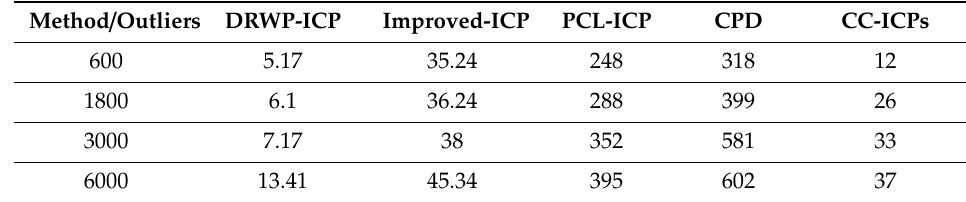
Table 6. Alignment times (seconds).